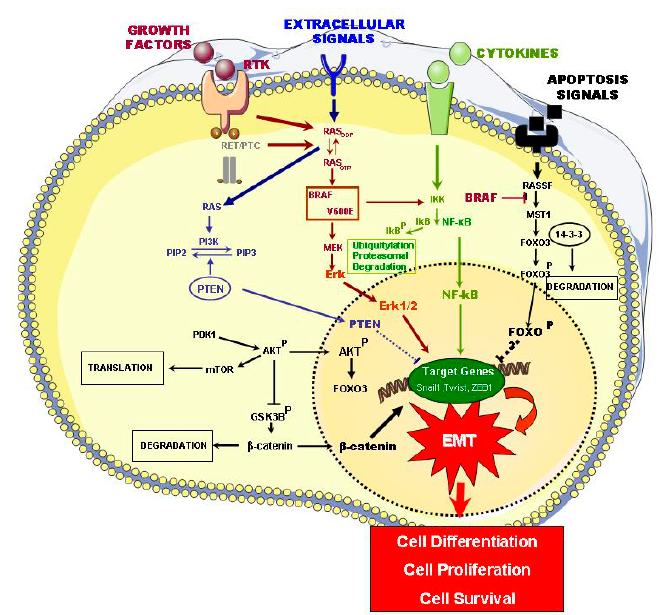
Figure 1. Schematic representation of relevant signaling pathways that are involved in epithelial thyroid carcinogenesis (ETC) and their link with epithelial mesenchymal transition (EMT) process. Part of Servier Medical Art by Servier is licensed under a Creative Commons Attribution 3.0 Unported License. (https: // smart.servier.com / image-set-download). Table 1. Main signaling pathways and gene mutations involved in thyroid carcinogenesis. Signaling Pathways A ff